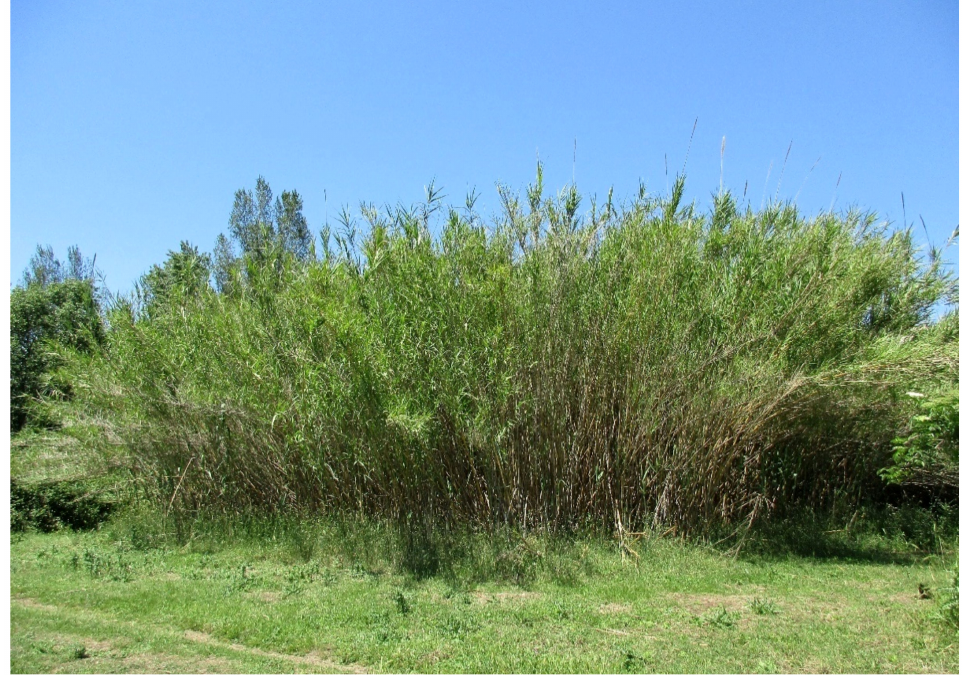
Figure 27. Arundo donax community (Divino Amore locality).